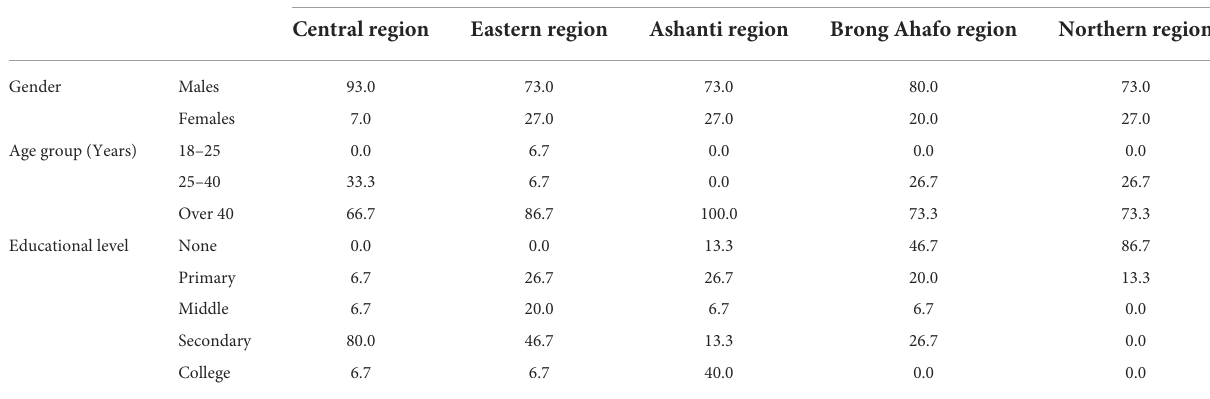
TABLE 2 Demographic data of the respondents.